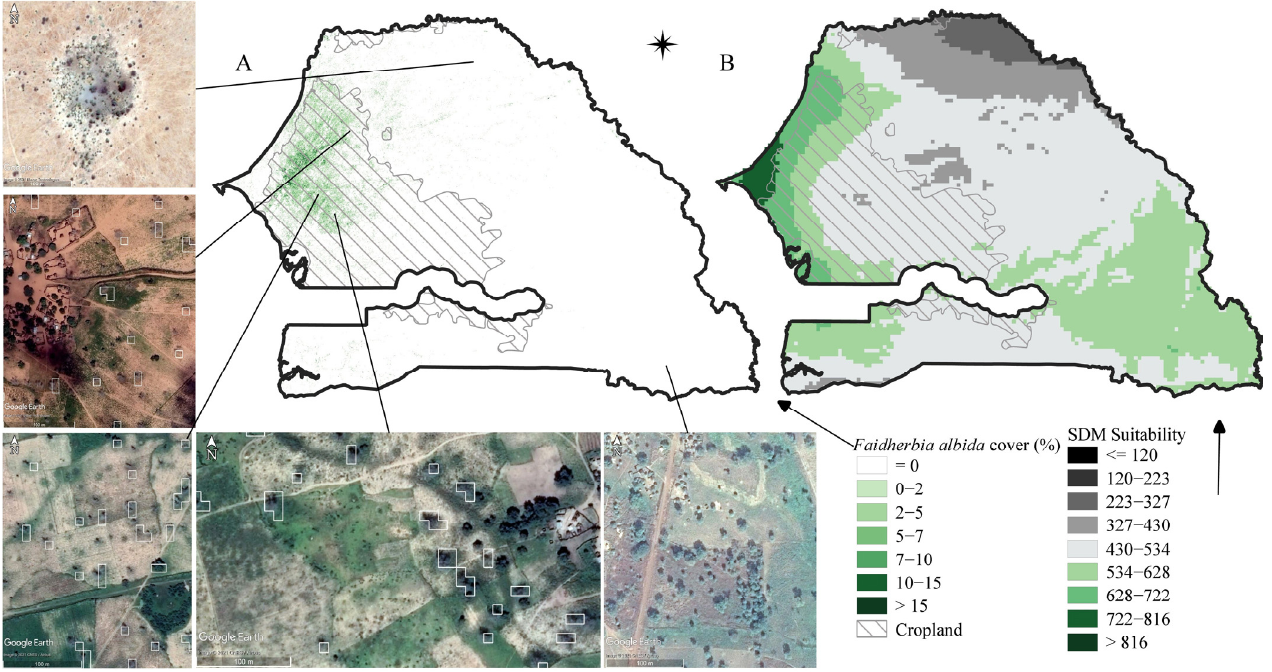
Figure 5. ( A ) Faidherbia albida cover map (%) at 1-hectare resolution from our classification. Included are close-up maps showing detailed Faidherbia albida classification maps of different regions as white polygons superimposed on images from Google Earth. ( B ) Faidherbia albida potential occurrence map provided by Kindt [64].